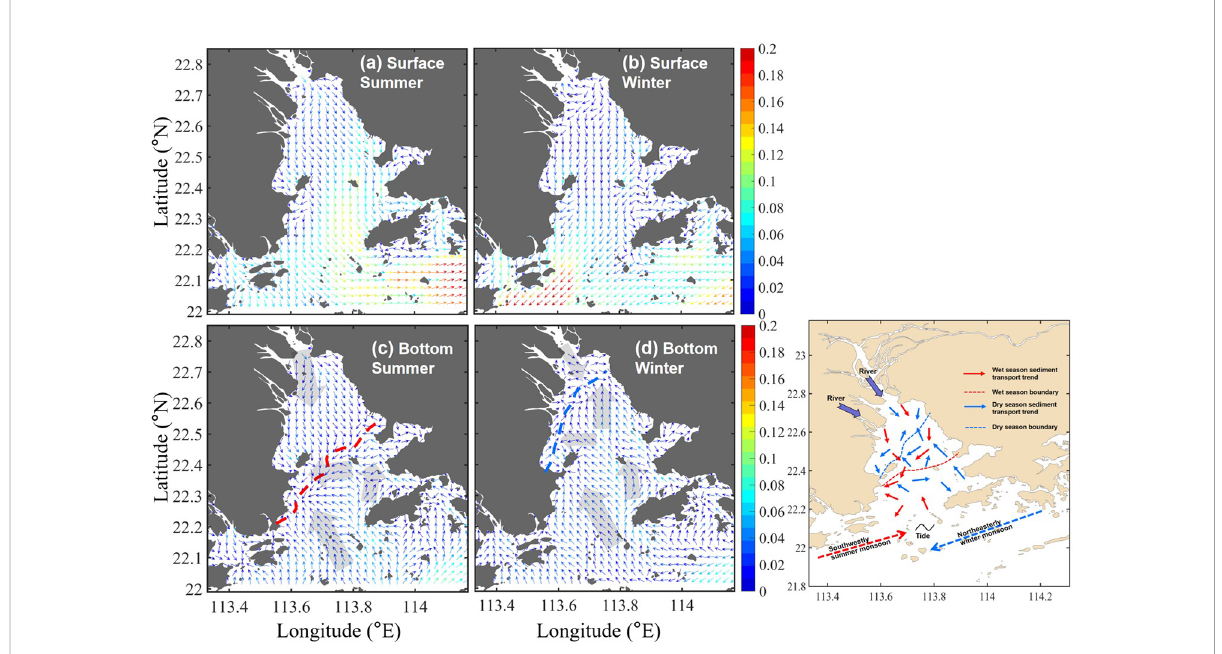
FIGURE 4 (A, B) The surface U L (m/s) averaged in the summer (June – August) and winter (December – February). The colors indicate the magnitude, and the arrows indicate the direction. (C, D) Same as (A, B) , except for the bottom U L . The transparent arrows indicate the mean pattern of the U L the Schematic map of the core transport path of the surface of the PRE sediment in summer and winter; the direction of coastal current is summarized by Xiao (2012); Li et al. (2014); Shi et al. (2015); Li and Li (2018); Zhang et al. (2019); Chu et al. (2020), and Wei et al.